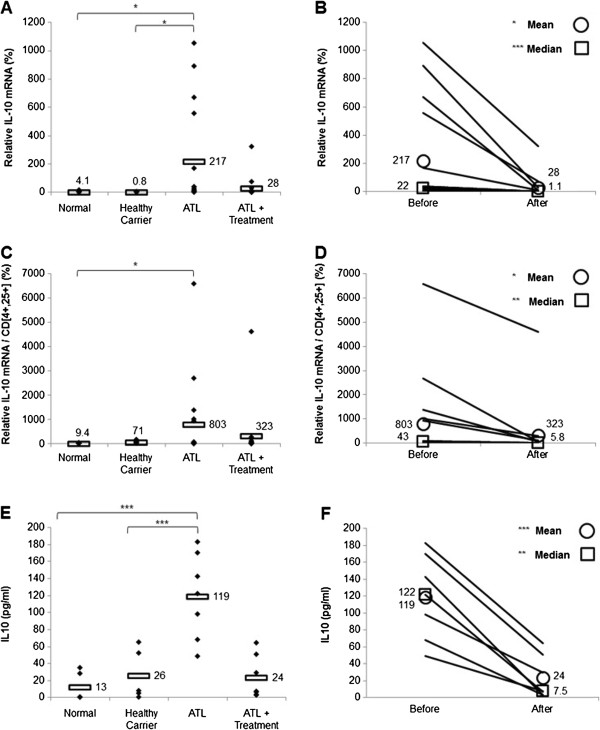
Treatment with arsenic/IFN/zidovudine decreased IL-10 expression and serum levels. A. IL-10 transcript levels in normal blood donors (n=10), healthy carriers of HTLV-I (n=10) and ATL patients (n=16) at initiation and 30 days after treatment with arsenic/IFN/zidovudine. Rectangles represent mean values. B. Mean and median IL-10 transcript levels of individual ATL patients at initiation and 30 days after treatment with arsenic/IFN/zidovudine. C, D. Relative expression of IL-10 transcripts after normalization to the number of CD4+CD25+ ATL cells. All values are expressed as percentage of human beta2-microglobulin used as internal control. E, F. Levels of secreted IL-10 in the serum of the seven ATL patients who displayed elevated pretreatment IL-10 serum level, measured by ELISA before and after treatment. *, **, *** indicate p values less than 0.05, 0.01 and 0.001 respectively.